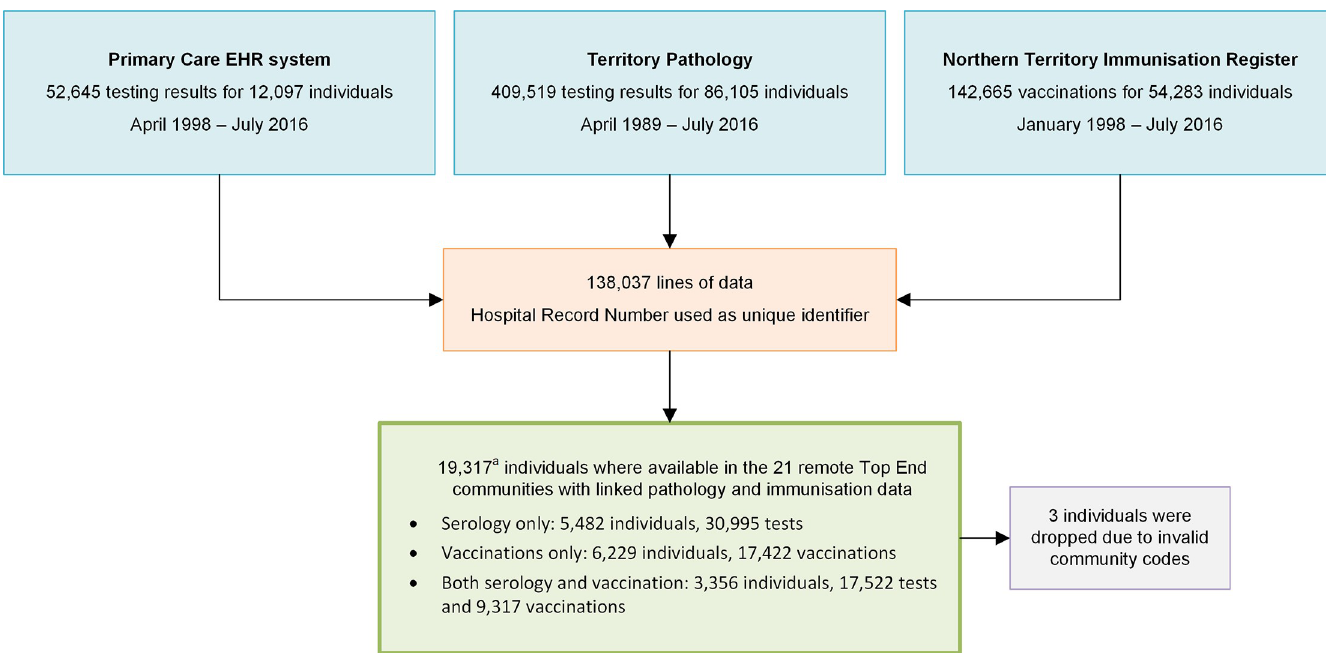
Fig 1. Flow diagram detailing sources of pathology and vaccination data and production of dataset, with duplicate tests and individuals removed. a includes non- Indigenous residents of the remote communities.